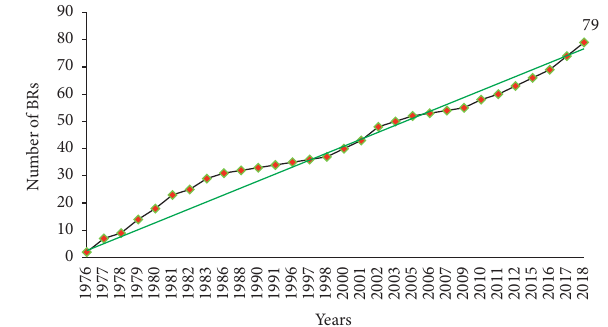
Figure 1: Biosphere reserves establishment history in Africa. Source: